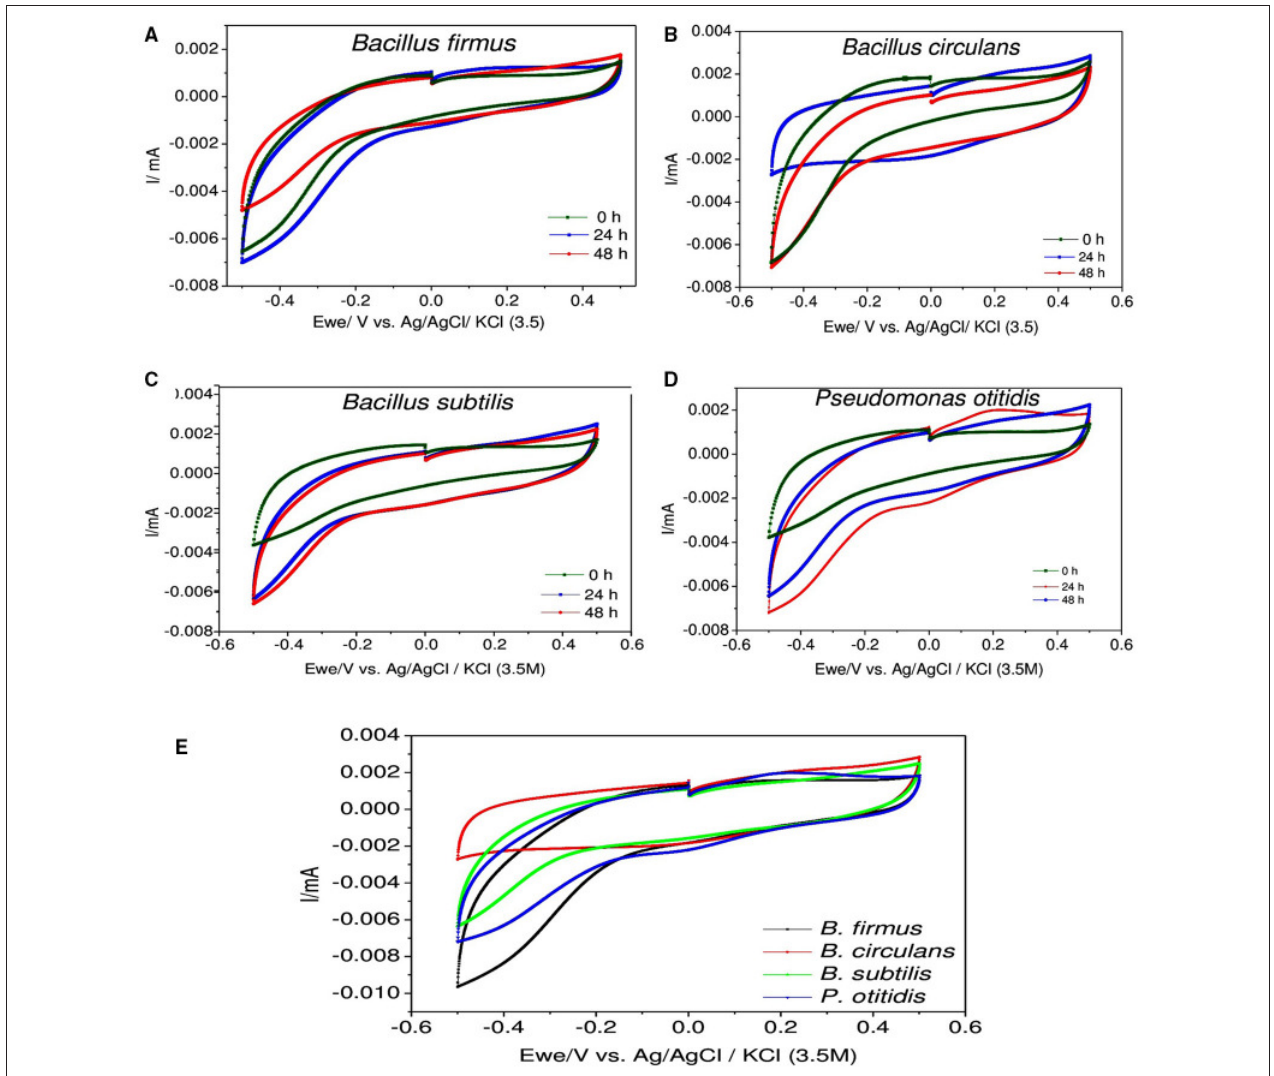
FIGURE 6 | Cyclic voltammograms depicting the redox catalytic currents in (A) Bacillus firmus , (B) Bacillus circulans , (C) Bacillus subtilis , (D) Pseudomonas otitidis, and (E) All isolated strains at specific 24h recorded at a scan rate of 20mV s − 1 .